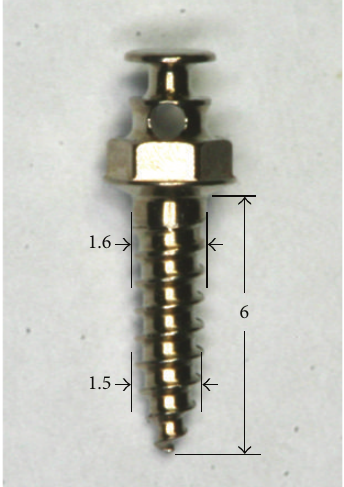
Figure 1: Orthodontic mini-implant used for this study. The size is 1.6 mm at the neck and 1.5mm at the apex in external diameter and 6 mm in length (Jin-E Screw, Jin Biomed Co., Bucheon,